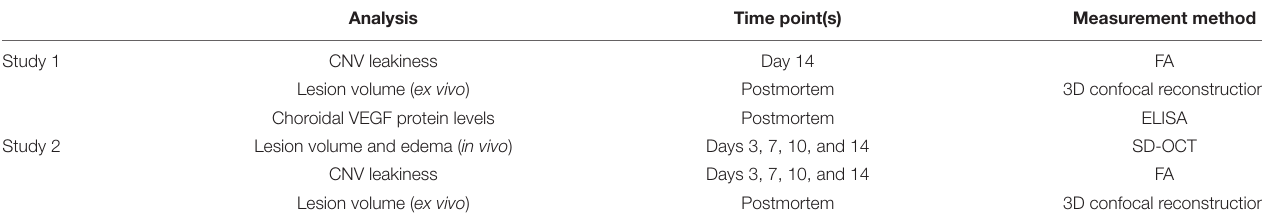
TABLE 1 | Analyses performed to track CNV progression following laser injury (day